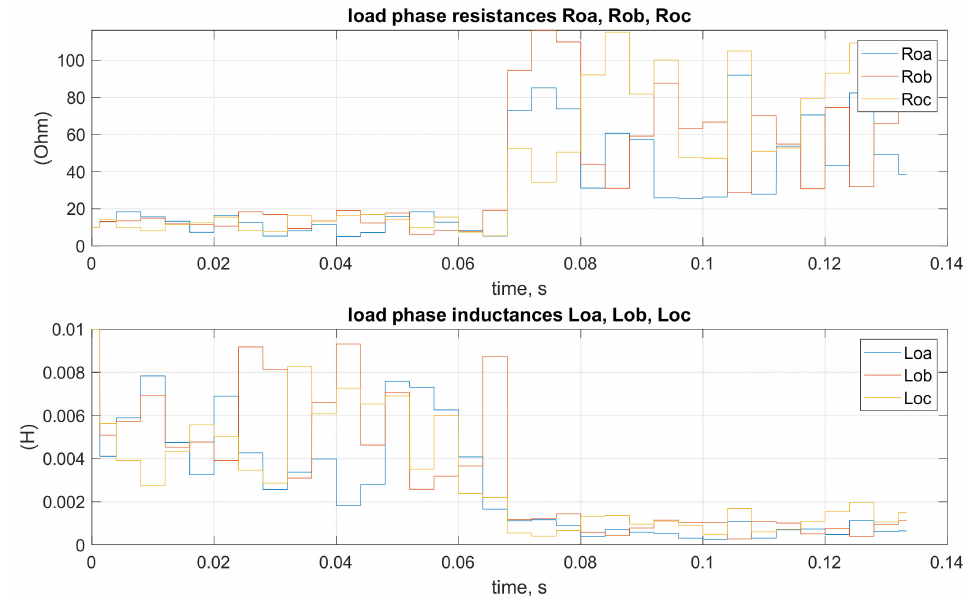
Figure 9. Waveforms of load phase resistances and inductances with a steep drop in load at the time of 0.068